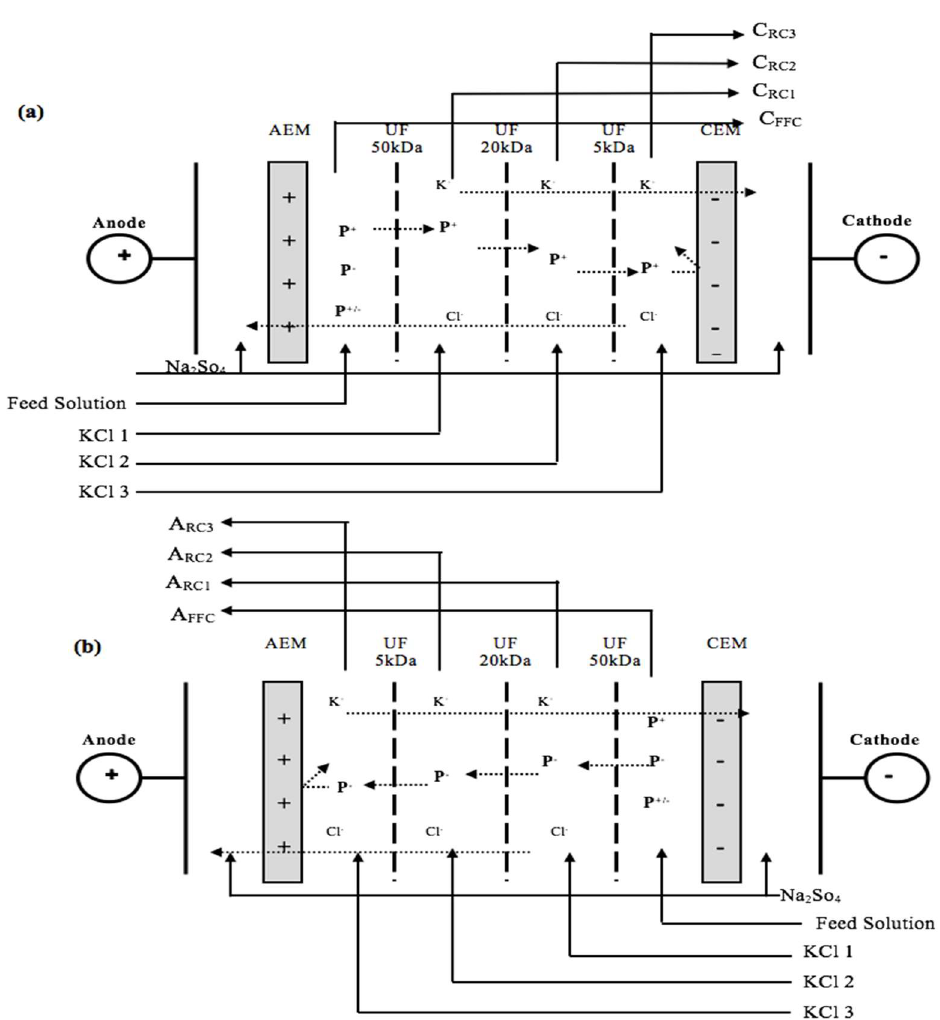
Figure 4. Layout showing EDUF membrane configurations, ( a ) cationic and ( b ) anionic, for the fractionation of the feed solution, which was an Unfractionated Salmon Protein Hydrolysate (U SPH ). AEM: anion-exchange membrane, CEM: cation exchange membrane, UF membrane: ultrafiltration membrane, P + : cationic peptides; P - : anionic peptides, P +/ − : neutral peptides, A RC : anionic recovery compartments, and C RC : cationic recovery compartments.